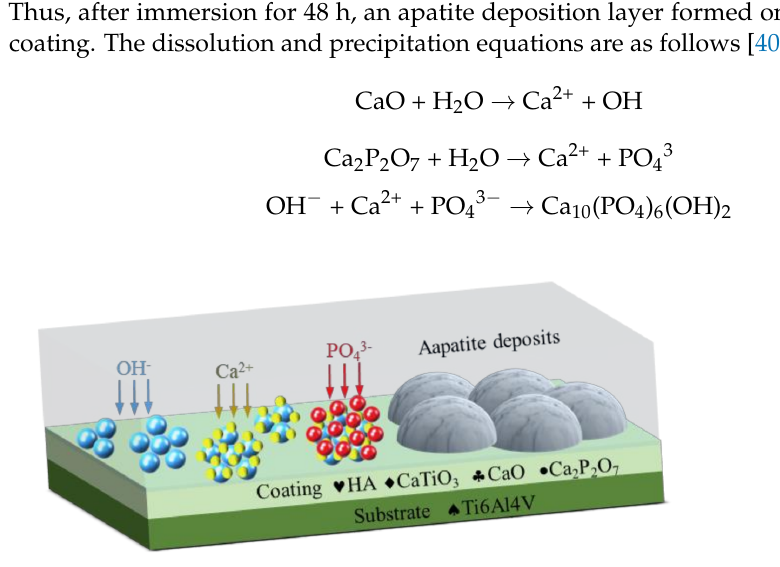
Figure 13. Schematic diagram of coating induced deposition of apatite.